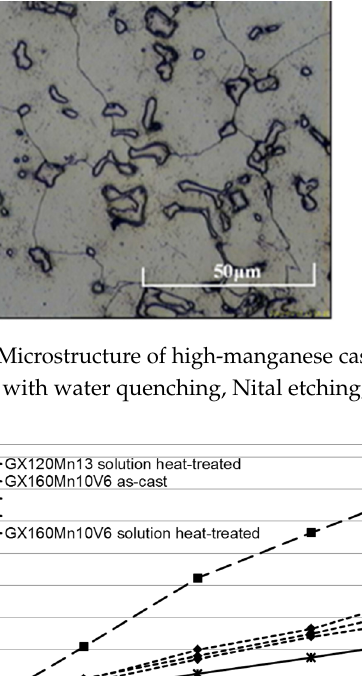
Figure 3. Microstructure of Hadfield cast steel with the addition of chromium (1.4%) after solution heat treatment with water quenching (1200 °C/80 min); austenitic matrix with undissolved carbides visible at the grain boundaries; Nital etching, [4].